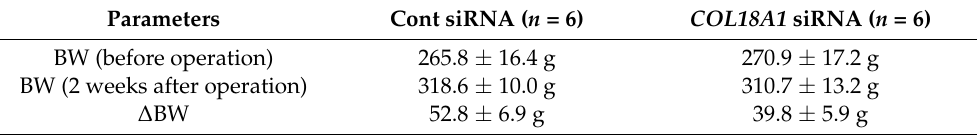
Table 1. Body weight (BW) in small interference (si) RNA-injected myocardial infarction model rats. Parameters